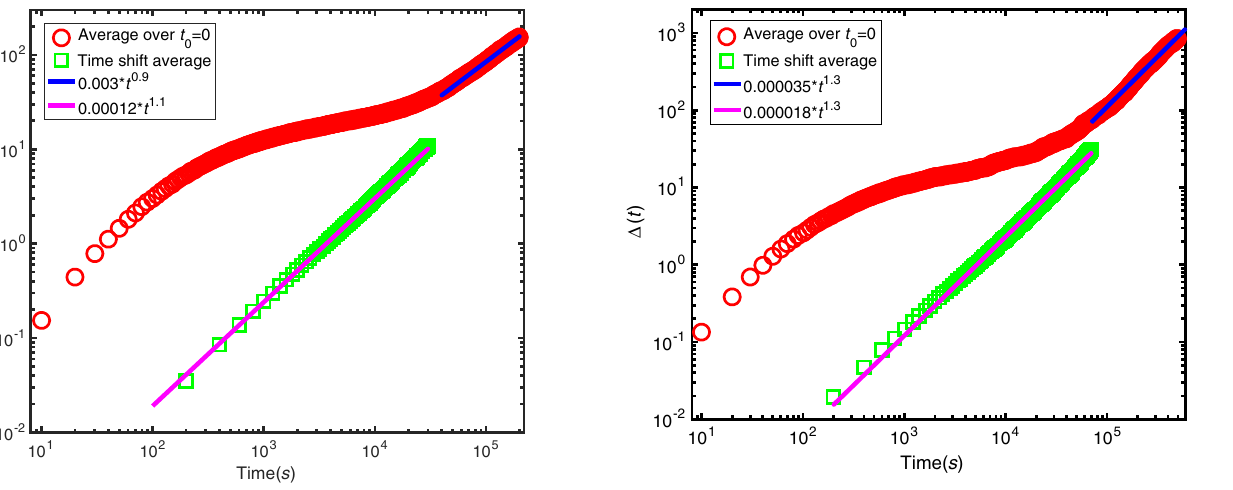
FIG. 17. Mean-square displacement Δ ð t Þ of cells as a function FIG. 16. The mean-square displacement [ Δ ð t Þ ] of cells of time. The red circles show the results obtained by averaging when cell death rate depends on time. The red circles show over the initial cell positions, Δ ð t Þ ¼ h½ r ð t Þ − r ð 0 Þ(cid:3) 2 i . The green the results obtained by averaging over initial cell position, squares are the results under the time shift average, Δ ð t Þ ¼ Δ ð t Þ ¼ h½ r ð t Þ − r ð t 0 Þ(cid:3) 2 i . The green squares show the results 0 ¼ h½ r ð t i þ t Þ − r ð t i Þ(cid:3) 2 i . The solid lines show the power-law fitting t Þ − calculated using the time shift average, Δ ð t Þ ¼ h½ r ð t i þ of the simulation data. The long time superdiffusive behavior is 2 i . The solid lines show power-law fits to the simulation r ð t i Þ(cid:3) evident in both plots. Here τ ¼ τ data. Normal diffusion results from the use of Eq. (16) lead to min homeostasis at long times.